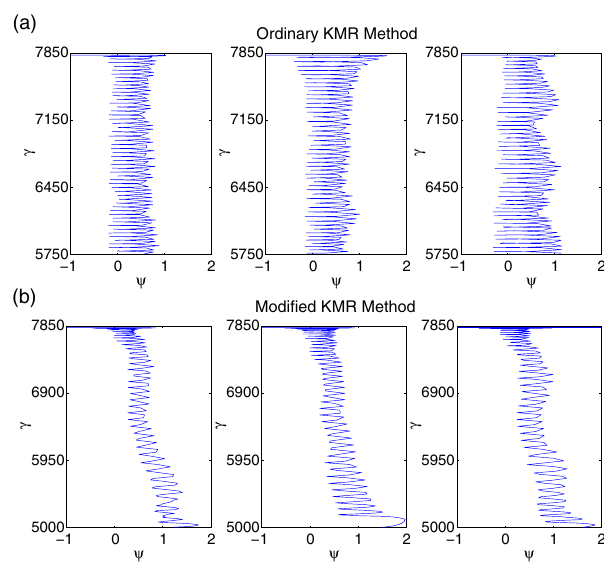
FIG. 3. Particle traces in the ð ψ ; γ Þ phase space for the ¼ 0 . 26 rad) and (b) modified (a) ordinary KMR method (with ψ R KMR method (with g ¼ 5 mrad = m). For each of the two methods, the trajectories of three representative, trapped particles are shown.